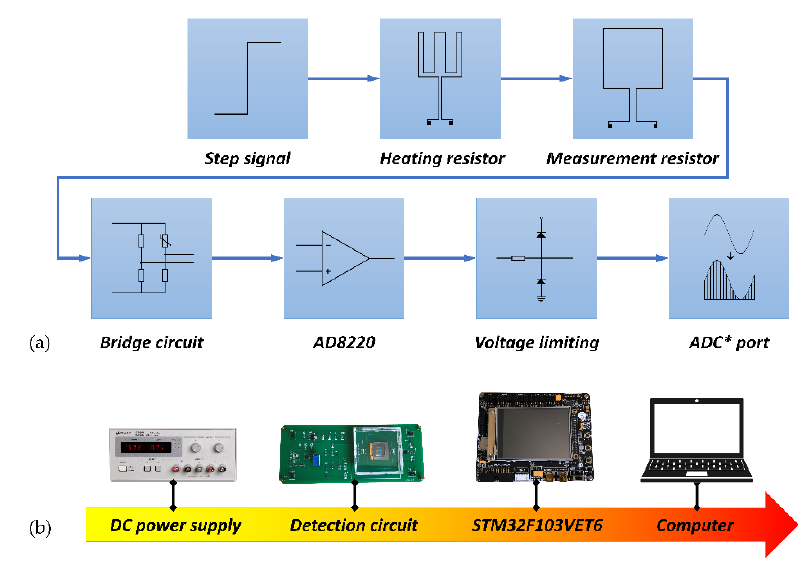
Figure 4. System identification experiment. ( a ) Flow chart for identifying the transfer function of the controlled plant; ( b ) hardware flow of the experiment.